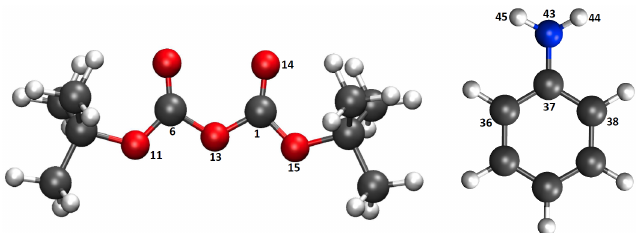
Atom labeling for Merz–Singh–Kollman (ESP) and electron localization function (ELF)/noncovalent interaction (NCI) analysis. Atom coloring is same as in Figure